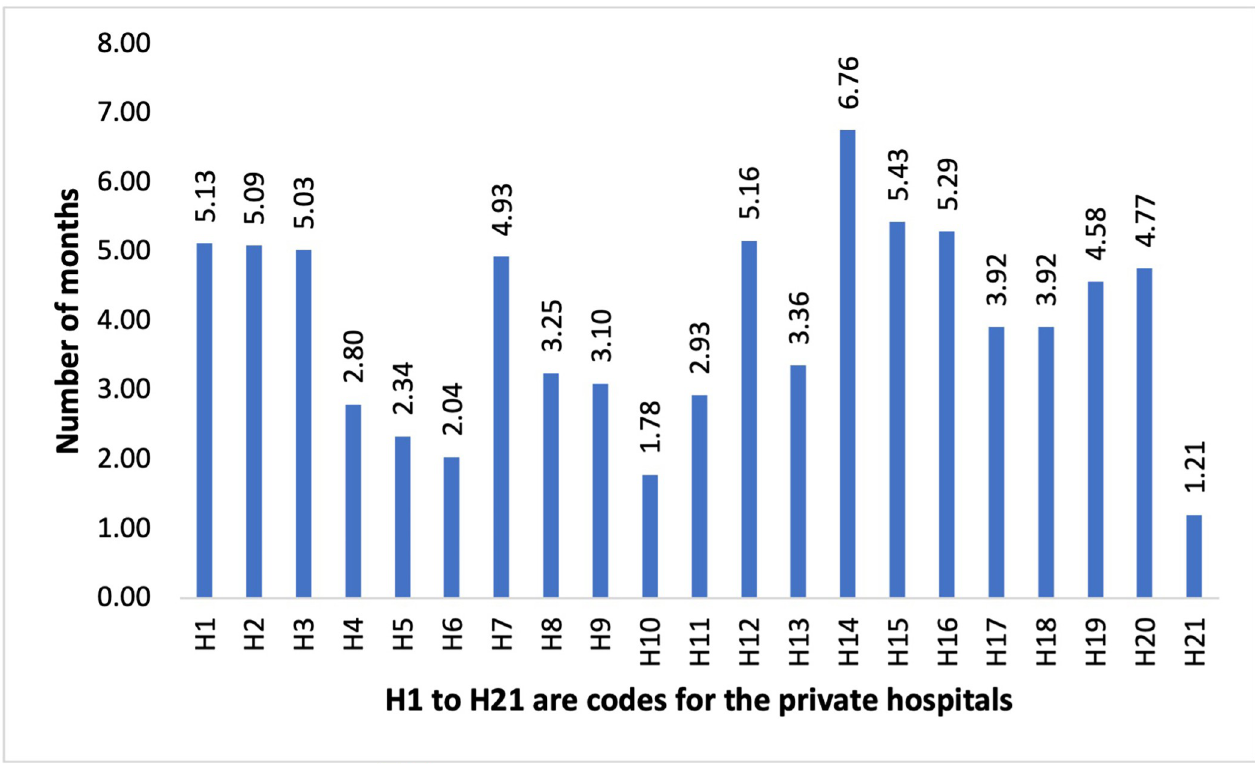
Fig 1. Total time taken for data collection for each facility (in